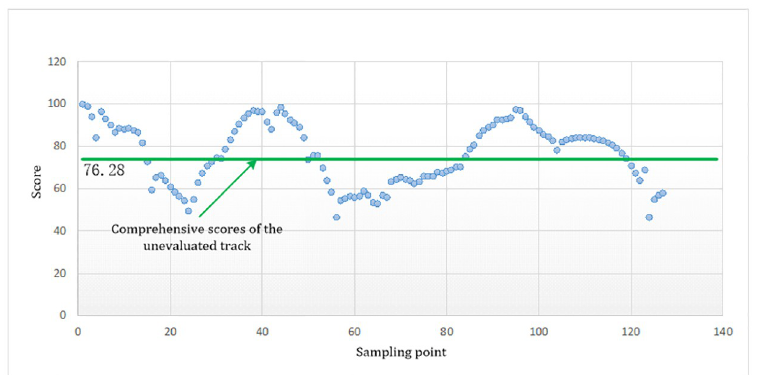
Fig 13. Comprehensive scores of the unevaluated